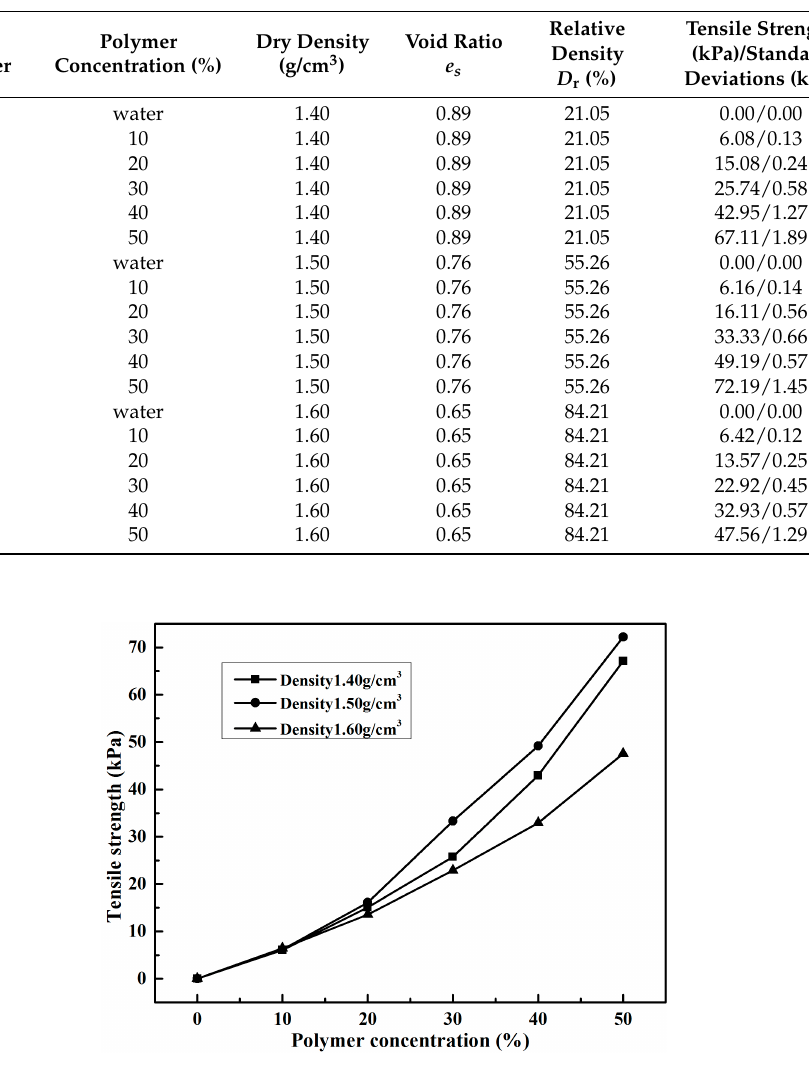
Figure 12. The variation of tensile strength with polymer concentration.